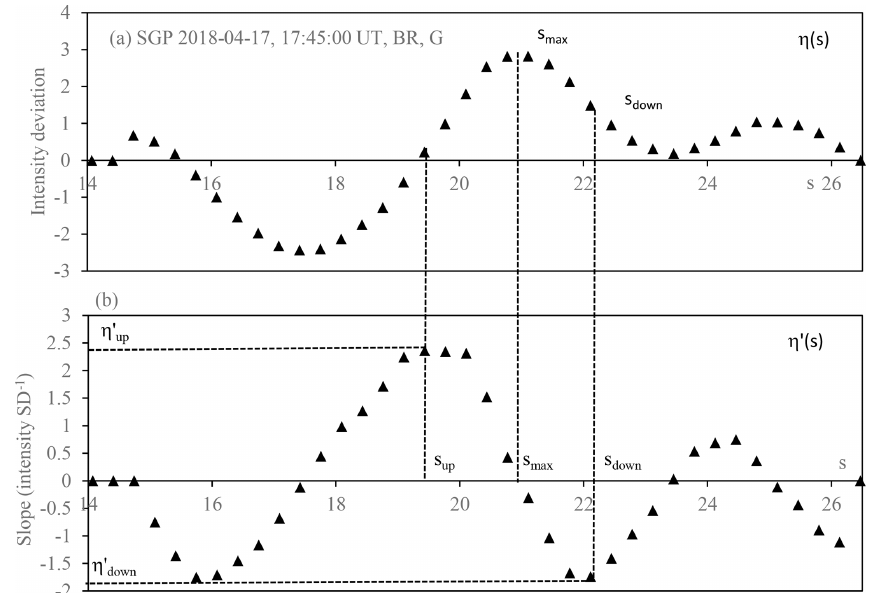
Figure 7. Radial markers used in halo scoring. The data belong to the green channel of the TSI image from SGP, 17 April 2018; see Fig. 2. (a) shows the radial intensity deviation η(s) ; (b) shows its derivative η (cid:48) (s) . Units are color value units (0 to 255) for the intensity and LSM units for the radial distance. The sequence of radial locations used in halo scoring is indicated, as well as the interpretation of the up- and downslope